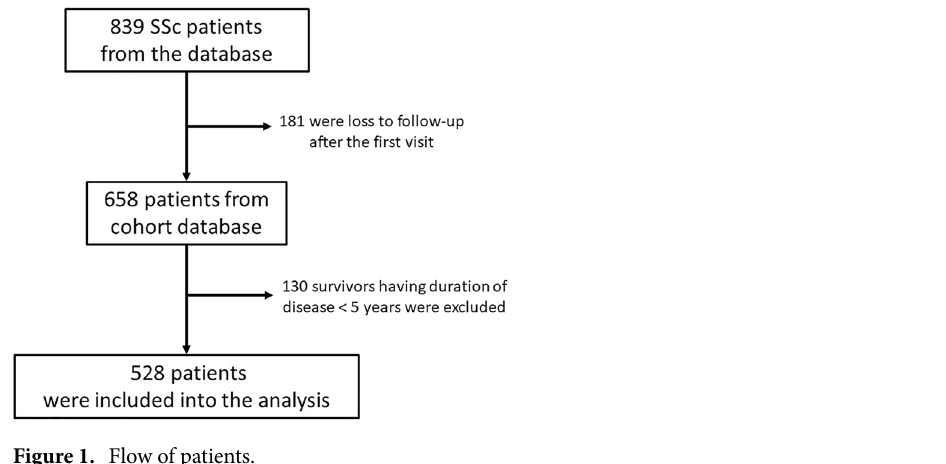
Figure 1. Flow of